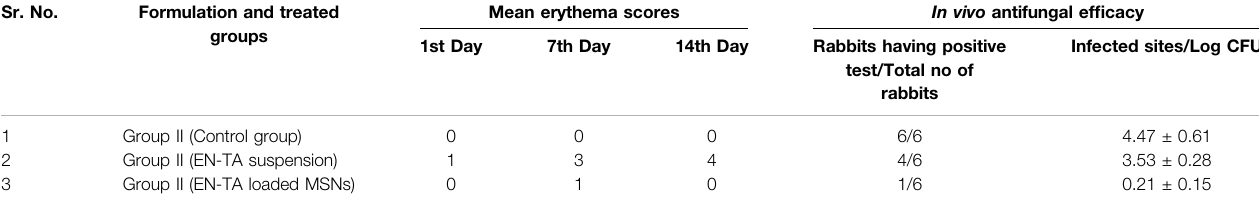
TABLE 5 | Mean erythema scores found for various formulations and in vivo antifungal studies in three groups of rabbits. Sr.